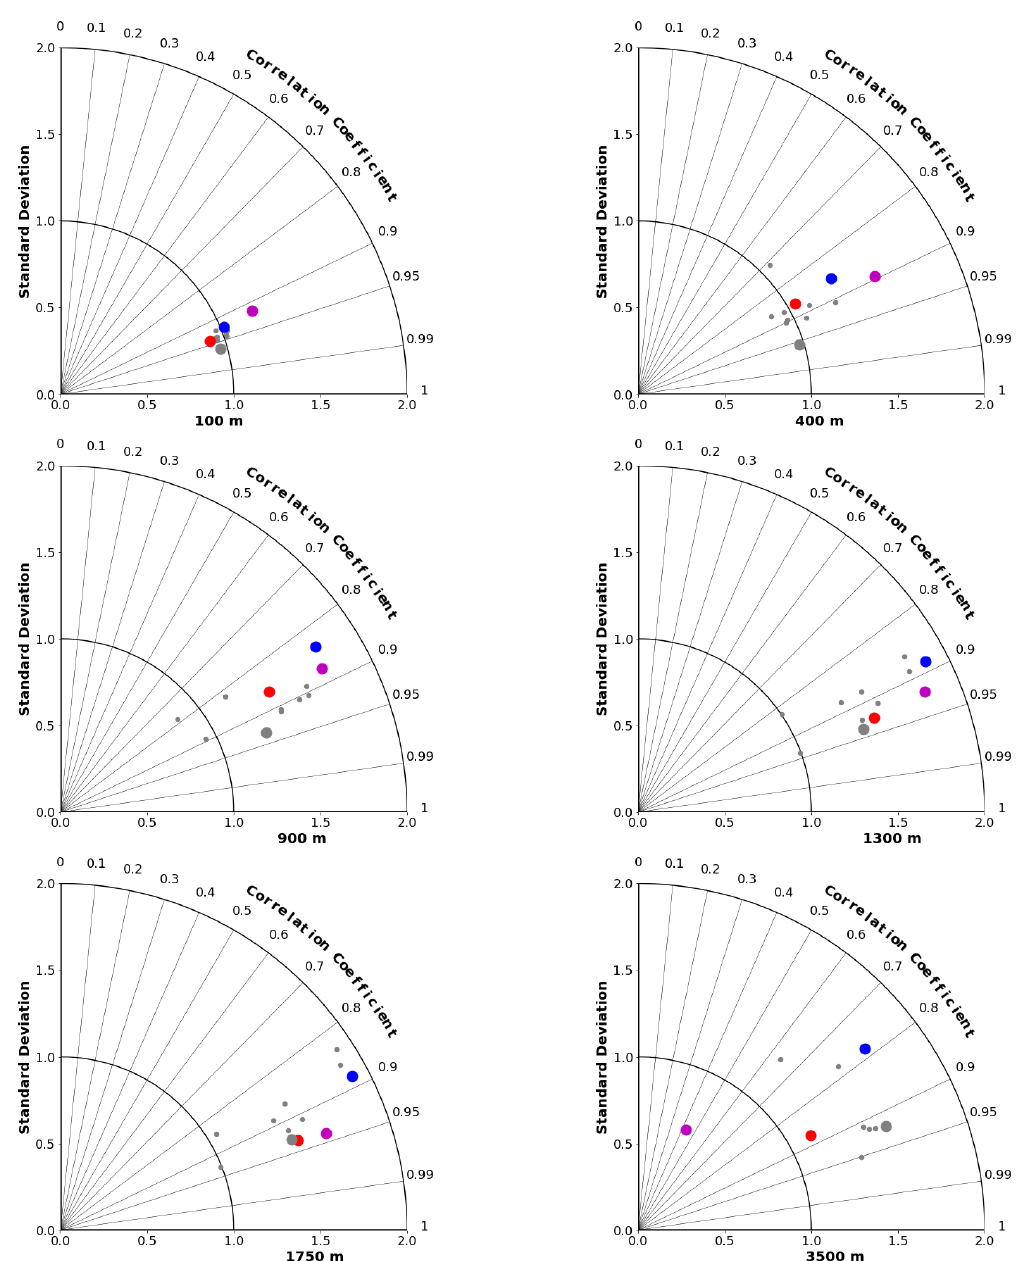
Figure 9. Taylor diagrams comparing modelled and observed (GLODAPv2 and WOA2018) distributions of (cid:127) A at specific depths from 100 to 3500m. Symbol colours are as in Fig.